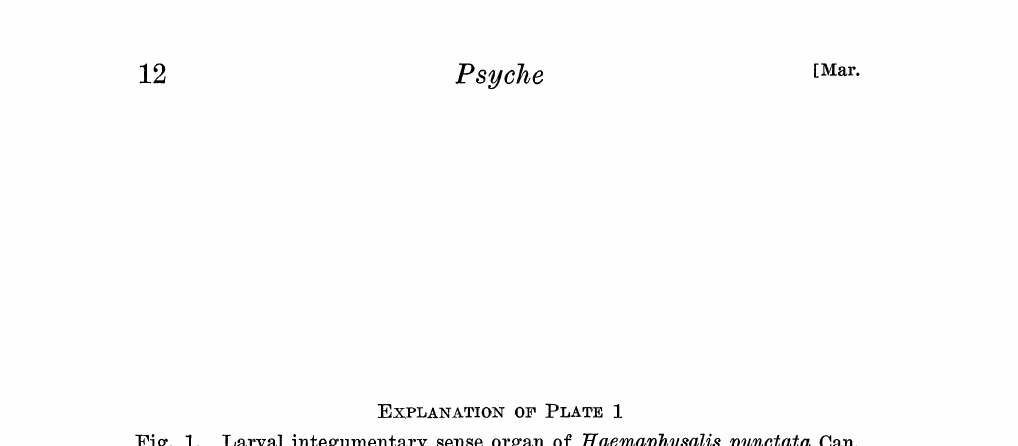
EXPLANATION 01 PLATE 1 Larval integumentary sense organ of Haemaphysalis punctata Can. and Fanz., redrawn from K. W. Neumann (1942). A, in direct view; B, in side view: al, sensory duct Bbl, internal vesicle; Bz, generative cell; C, cuticula; Dz, gland cell; Ityp, hypodermis; L, lips; Oe, mouth of the sensory duct 1, frame lm, fringe V, protrusions of the frame; Z, tooth. Schematic drawing of a sensillum sagittiforme of Hyalomma, after P. Schulze: Astr, axial fiber; Dp, projecting ledges; Dr, gland cell; Ek, terminal chamber; KEst, knot of the scolopale; NK, enveloping cell nucleus; Sch, tuft Schk, tuft chamber; Sg, sensory cell group outside the duct. The chitinous structure surrounding the sense organ has been omitted. Fig. 3. Schematic drawing of a sensillum auriforme on the alloscutum of a female Hyalonma, after P. Schulze: Astr, axial fiber; Dz, shaded zone of the disk; Gh, papilla with terminal apparatus in central area of the disk; Hz, unshaded zone; Nk, enveloping cell nucleus; Pa, pigmented and thickened section of the duct; Sk, sensory cell nucleus; Tf, supporting plicature. The chitinous structure sur- rounding the sensory organ and gland cells has been omitted. The disk covering the sensory cell and the terminal apparatus is assumed to be